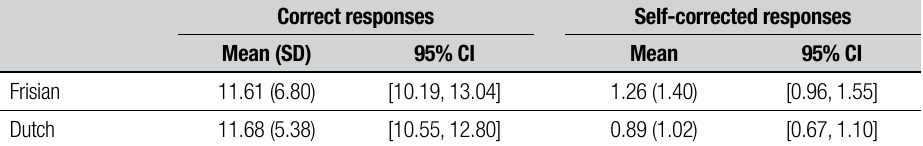
Table 1. Mean number of raw score (n max 90) correct and self-corrected responses (with standard deviations and 95% C.I. - confidence intervals) per target word in Frisian and Dutch.